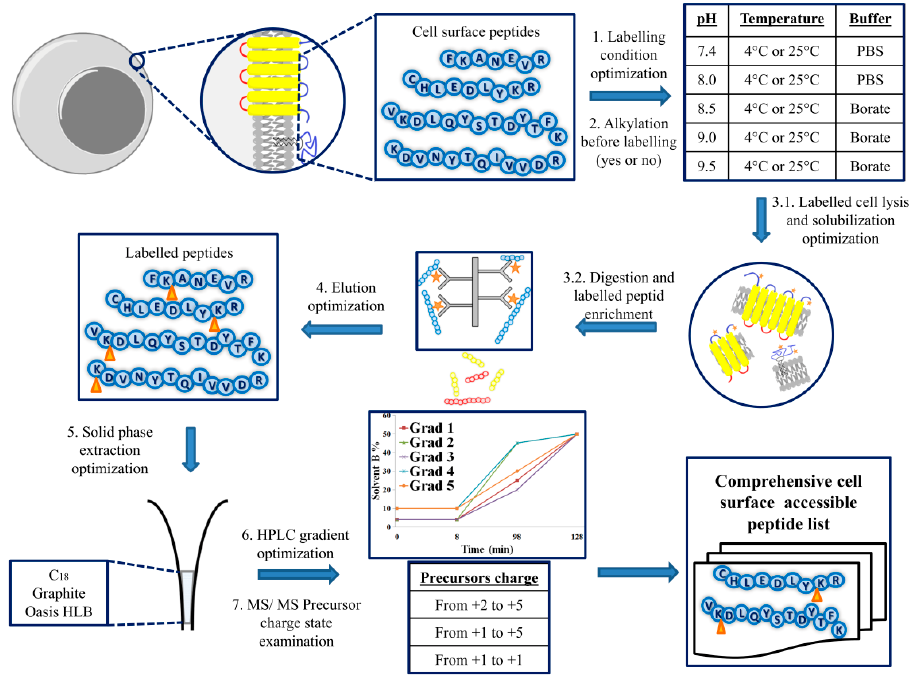
Figure 1. Flowchart of the optimized cell surface peptide characterization method. Cell surface proteins of the isolated cells are modified with a membrane-impermeable, primary amino group- specific biotinylation agent (Sulfo-NHS-SS-biotin) in different labeling conditions (the upper right corner). The efficiency of the cell surface peptide modification is monitored with or without alkylating agent (iodoacetamide) under the cell isolation process using the most efficient labeling condition. Thereafter, the cells are lysed, and plasma membranes are isolated and solubilized, avoiding endogen proteolysis under these steps. Then membrane-binding proteins (as transmembrane or other membrane-associated proteins) are digested with trypsin in a detergent- containing environment, and the modified peptides are purified on an optimal amount of high- capacity neutravidin agarose resin. Then biotinylated peptides are eluted by two consecutive incubations with DTT (dithiothreitol; the elution condition is optimized with biotinylated bovine serum albumin). Modified extracellular peptides are purified on one of the three different solid phases (performance of four methods investigated) that can be specific for different kinds of peptides. Finally, the enriched peptides are analyzed using nanoHPLC-MS/MS, examining various chromatographic separations (performance of five different gradients investigated) and adjusting the precursor charge state preferences (three setting parameters investigated) under tandem mass spectrometry analysis to find the optimal parameters of the developed method for the comprehensive modified peptide identification from the model cell surface. The light blue color marks the extracellular segments of the cell surface proteins. Furthermore, in the case of TMPs, yellows are transmembrane segments, and reds are their intracellular parts. The orange stars indicate the Sulfo-NHS-SS-biotin labeling, and the orange triangles after the elution are the remnant region from the labeling agent on the appropriate residues. The numbered parts around the blue arrows are the optimized steps in the method presented here. The next sections are divided according to the optimized steps and discuss in detail the control experiments used (dot blot, Western blot, SDS-PAGE, etc.) as well as their results. Finally, we summarize all the identified cell surface labeled peptides from CSPs for the model HL60 cell line and assess the membrane- and cell surface-protein specificity of the developed method. The correctness of extracellularly labeled positions from transmembrane proteins was checked using other experimental topology data collected in TOPDB [41].